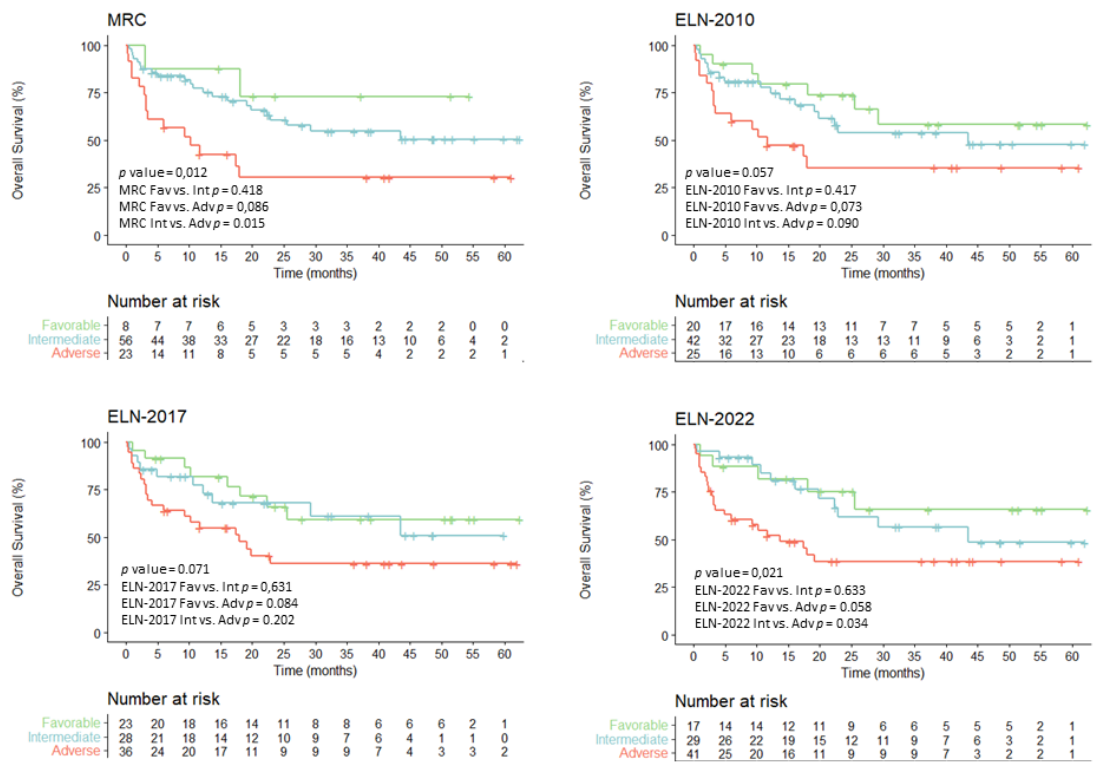
Figure 5. Overall survival probability for intensively treated patients ( n = 87) according to the evolving risk classifications.